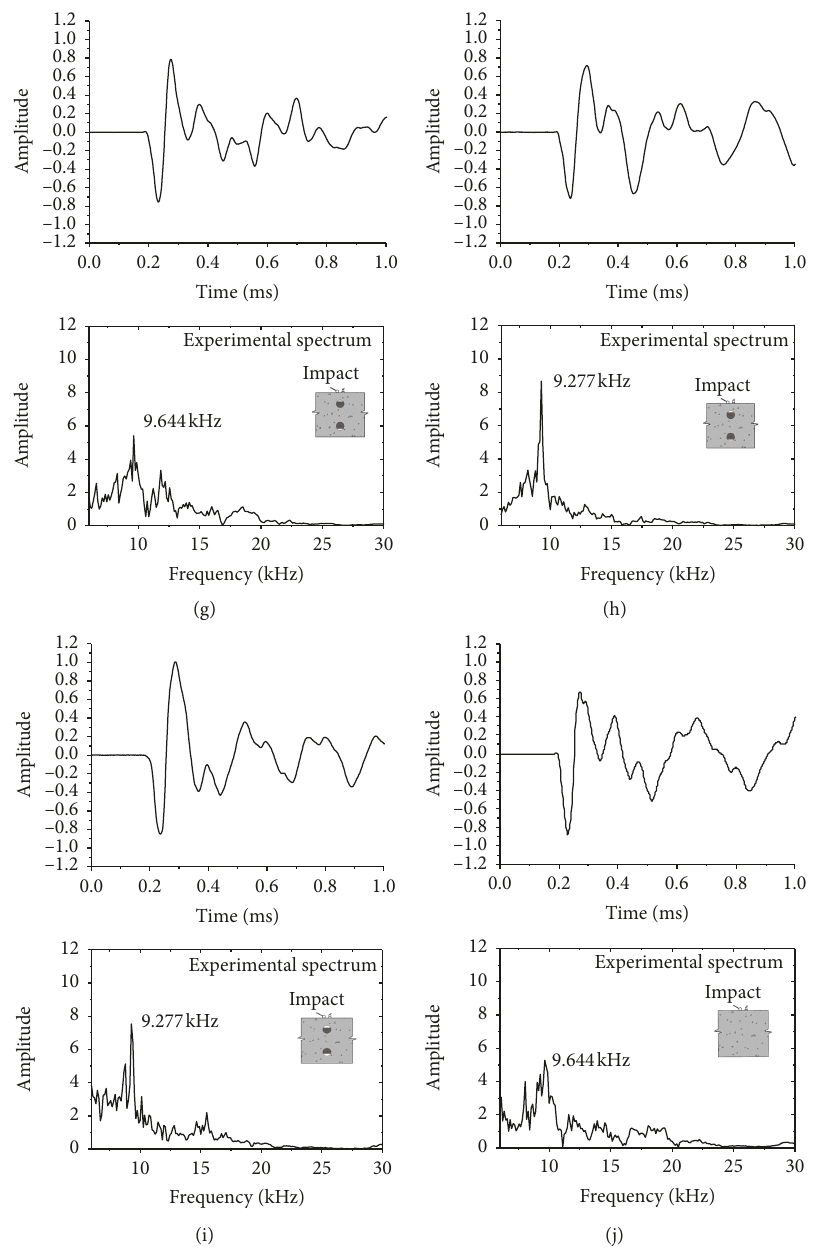
Figure 8: Waveforms and amplitude spectra obtained under different conditions. (a) Solid grout with reinforcement (hole A). (b) Solid grout without reinforcement (hole B). (c) Ungrouted (hole C). (d) Grout defect 10% at test surface 1 (hole D). (e) Grout defect 20% at test surface 1 (hole E). (f) Grout defect 30% at test surface 1 (hole F). (g) Grout defect 10% at test surfaces 1 and 2 (hole G). (h) Grout defect 20% at test surfaces 1 and 2 (hole H). (i) Grout defect 30% at test surfaces 1 and 2 (hole I). (j) Solid concrete (hole